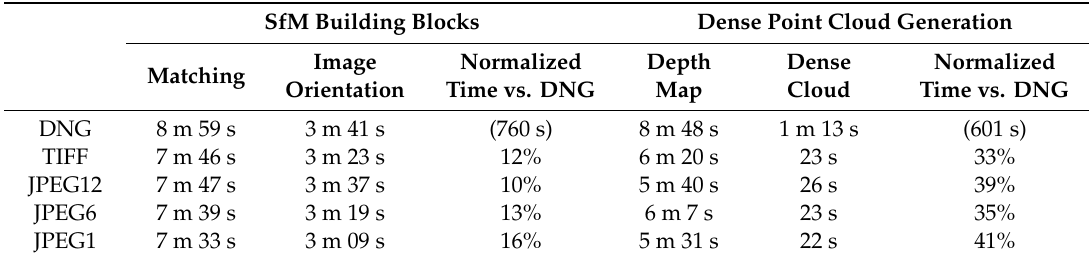
Table 13. Time processing for the experimentation on test site 1.